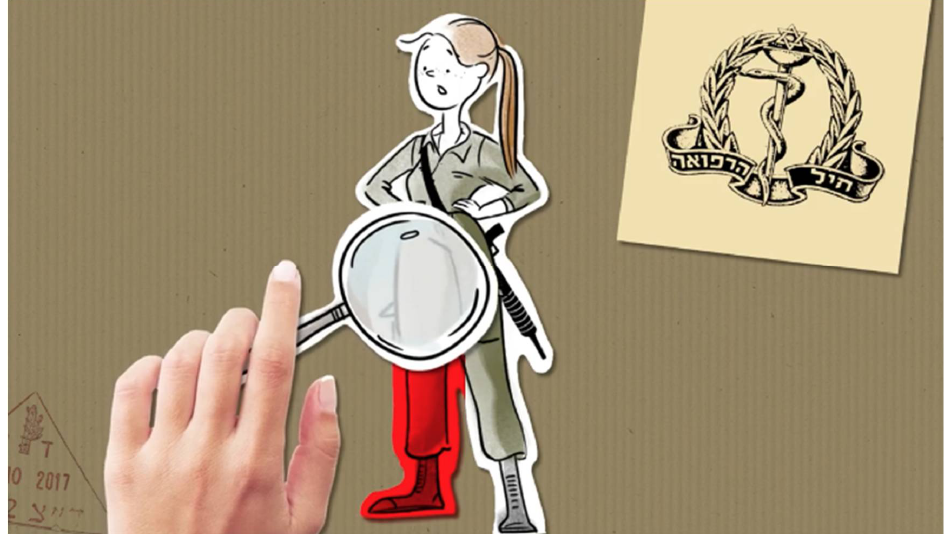
Figure 2. ‘Noa volunteers to become a fighter’ (The IDF Fortitude Forum, September 2017). [Hebrew wording in the picture: “Medical Corps”]. (Supplementary material).